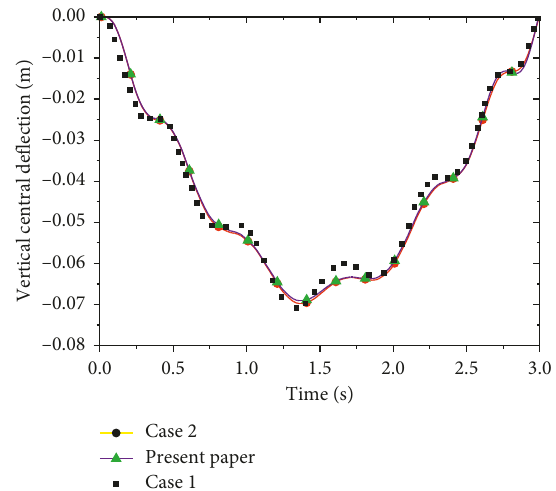
Figure 3: The calculated results for the central deflections using references [29,